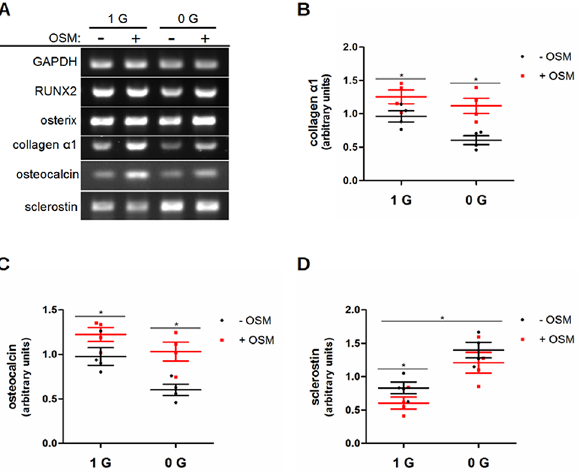
Fig 5. OSM and RCCS have independent and opposing effects on osteoblast activity. Markers of osteoblast maturation and activity were assessed by semi-quantitative RT-PCR for interactions between OSM signaling and RCCS. Representative images at 48 h are shown (A), when the largest effects were found. For markers affected by OSM or RCCS, the results of densitometry are shown as scatter plots with mean and SEM (B-D). OSM supplementation induced collagen α 1(I) (B) and osteocalcin (C) transcription, but had no significant effect on sclerostin transcription (D). RCCS inhibited the transcription of collagen α 1(I) and osteocalcin, while increasing transcription of sclerostin. No significant interaction between the factors was detected by